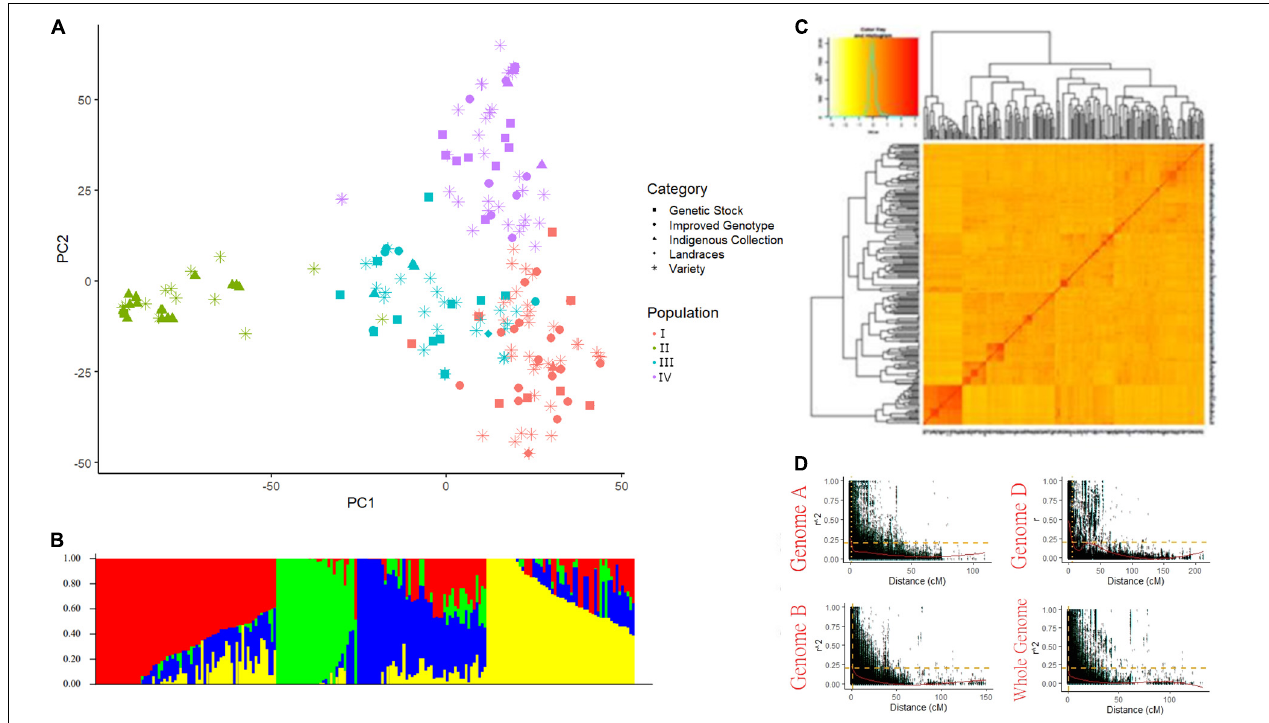
FIGURE 2 | Population structure of genome-wide association study (GWAS) panel consisted of 200 bread wheat genotypes (A) PCA plot, (B) Bar plot showing the number of optimum sub-population in GWAS panel, (C) Van Raden kinship matrix, and (D) Scatter plot showing LD decay in three sub-genomes and whole genome.